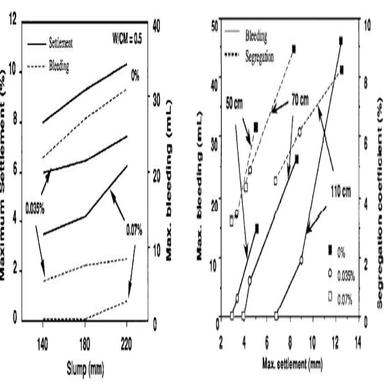
(left) Effect of welan gum content on surface settlement and external bleeding determined for concrete proportioned at different slump values cast in 70-cm high columns; (right) variations of bleeding, segregation, and settlement with VMA content and column height. Reproduced from with permission.